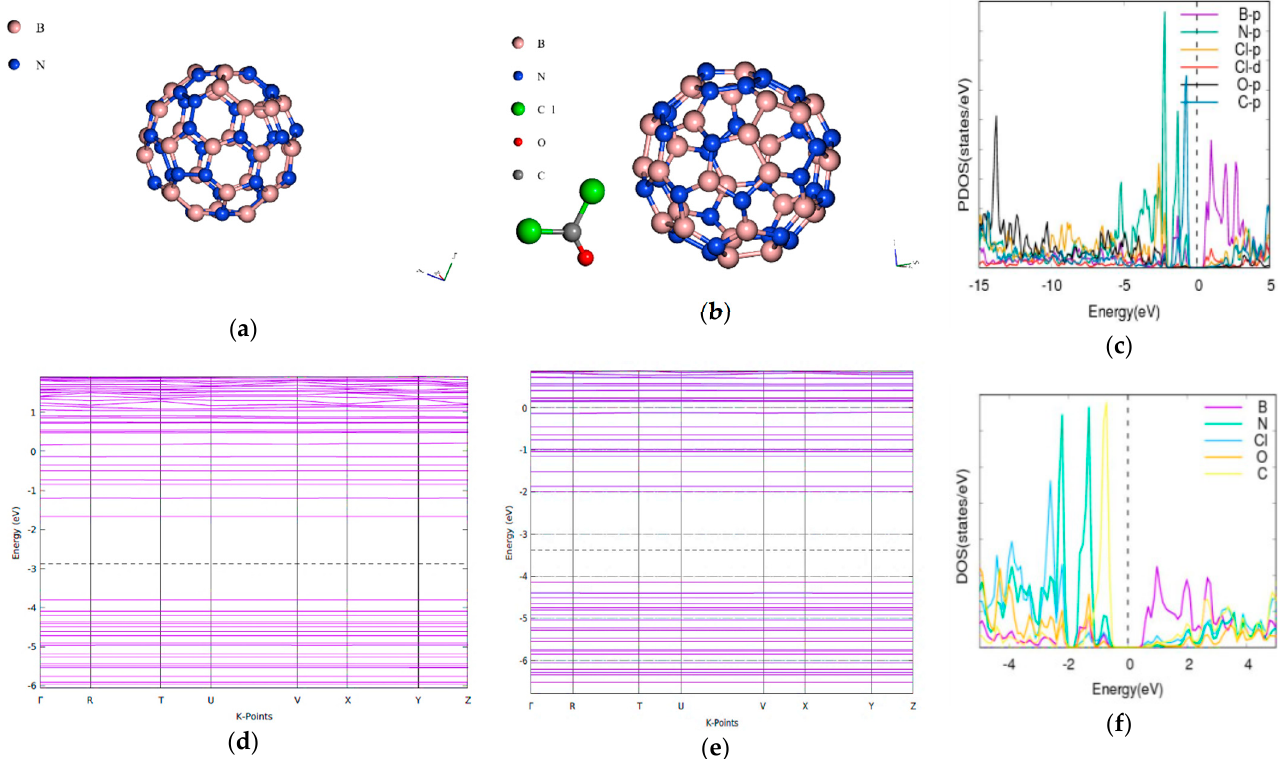
Figure 5. Band structure and density of states for phosgene gas interaction with BN60. ( a ) Pristine BN60, ( b ) phosgene- BN60, ( c ) phosgene-BN60 PDOS band-gap is ( d ) BN60 band structure Eg = 2.1454 eV, ( e ) phosgene-BN60 Eg = 2.1495 eV, ( f ) Phosgene-BN60 DOS.